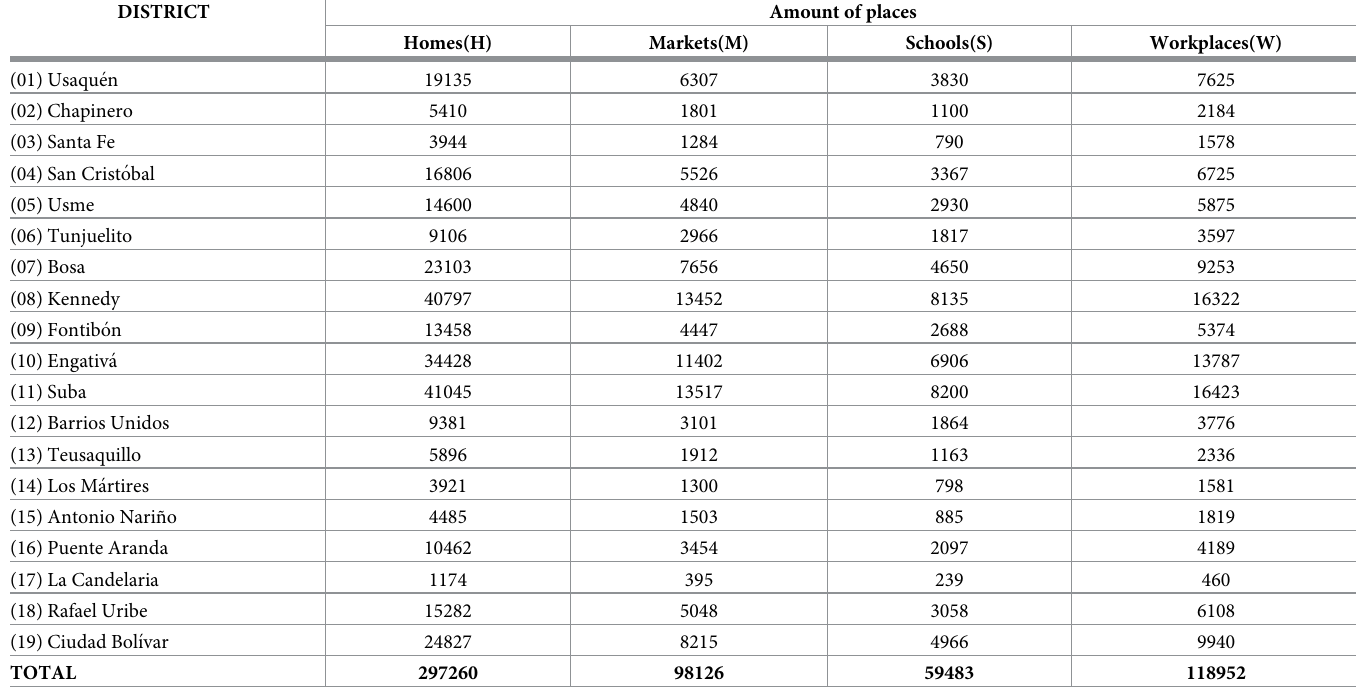
Table 2. Number of interest places generated by UPZ group by District